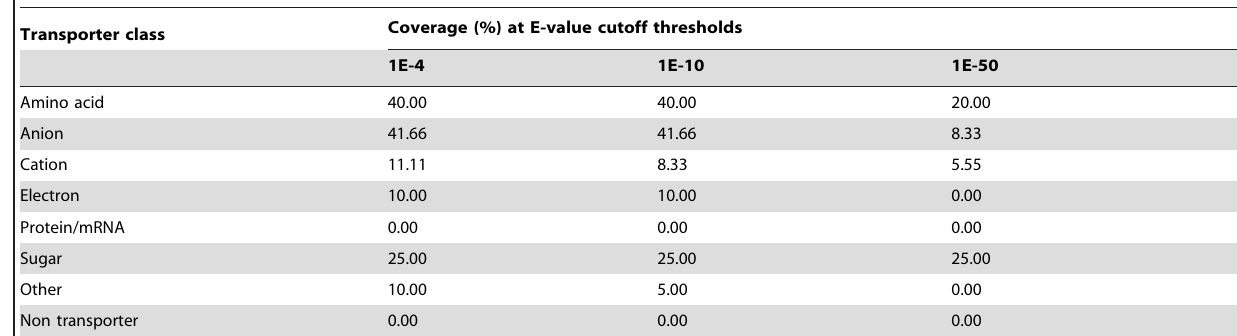
Table 11. The performance (coverage metric) of the HMM search on the independent dataset.